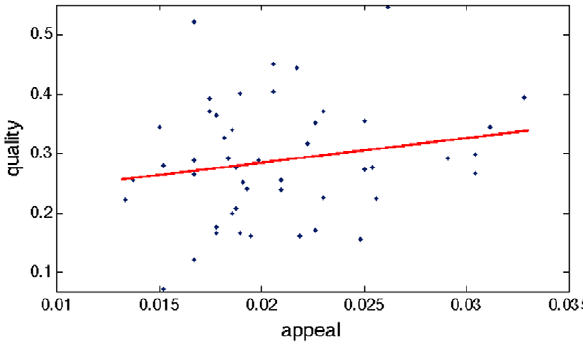
Figure 1. Quality and appeal are independent. Values are shown for quality and appeal corresponding to the 48 songs in Experiment 2, independent condition. R 2 =0.012.